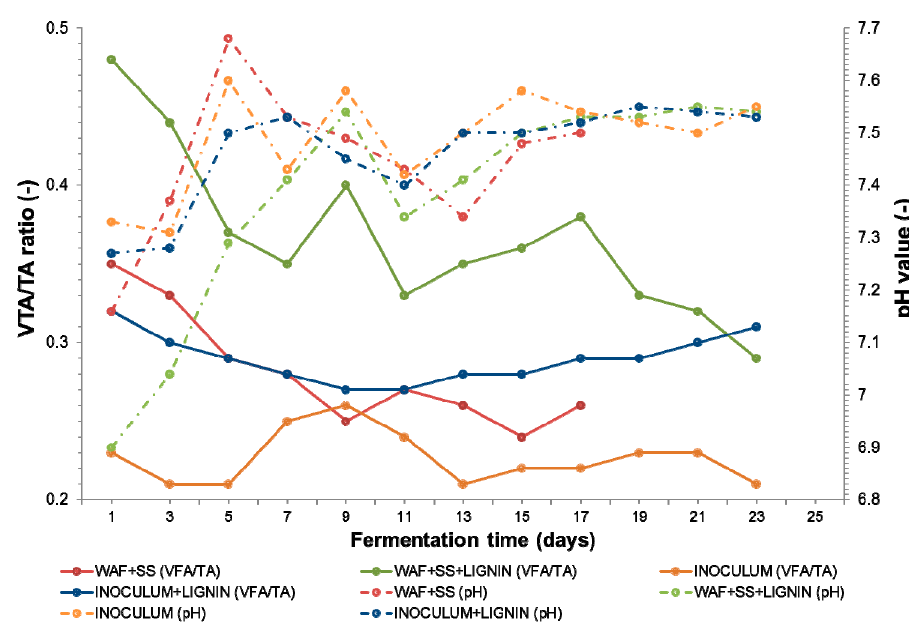
Figure 7. Variation in the pH and VFA/ total alkalinity (TA) ratio during the anaerobic digestion of the WAF+SS, WAF + SS + Lignin, Inoculum and Inoculum + Lignin samples.